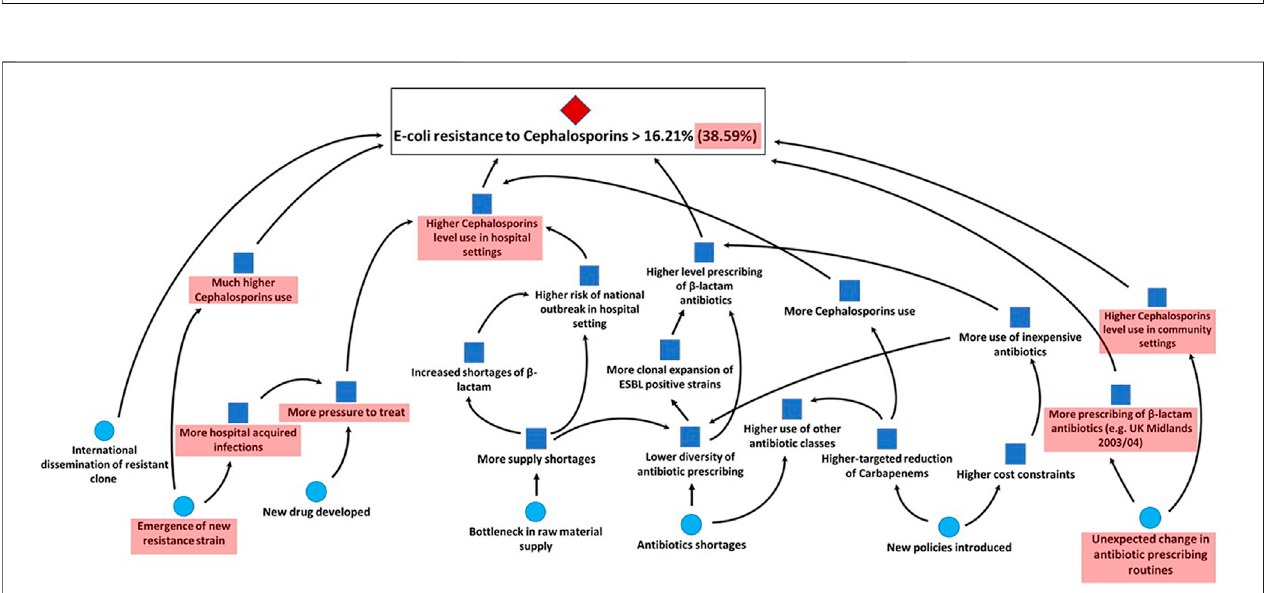
FIGURE4| Elicitedconditionalexceedanceprobabilitiesforthe50 th and 95 th quantiles (perexpert) with fi ttedcopulasthrough thetaildependence coef fi cient foru between 0.5 and 1.